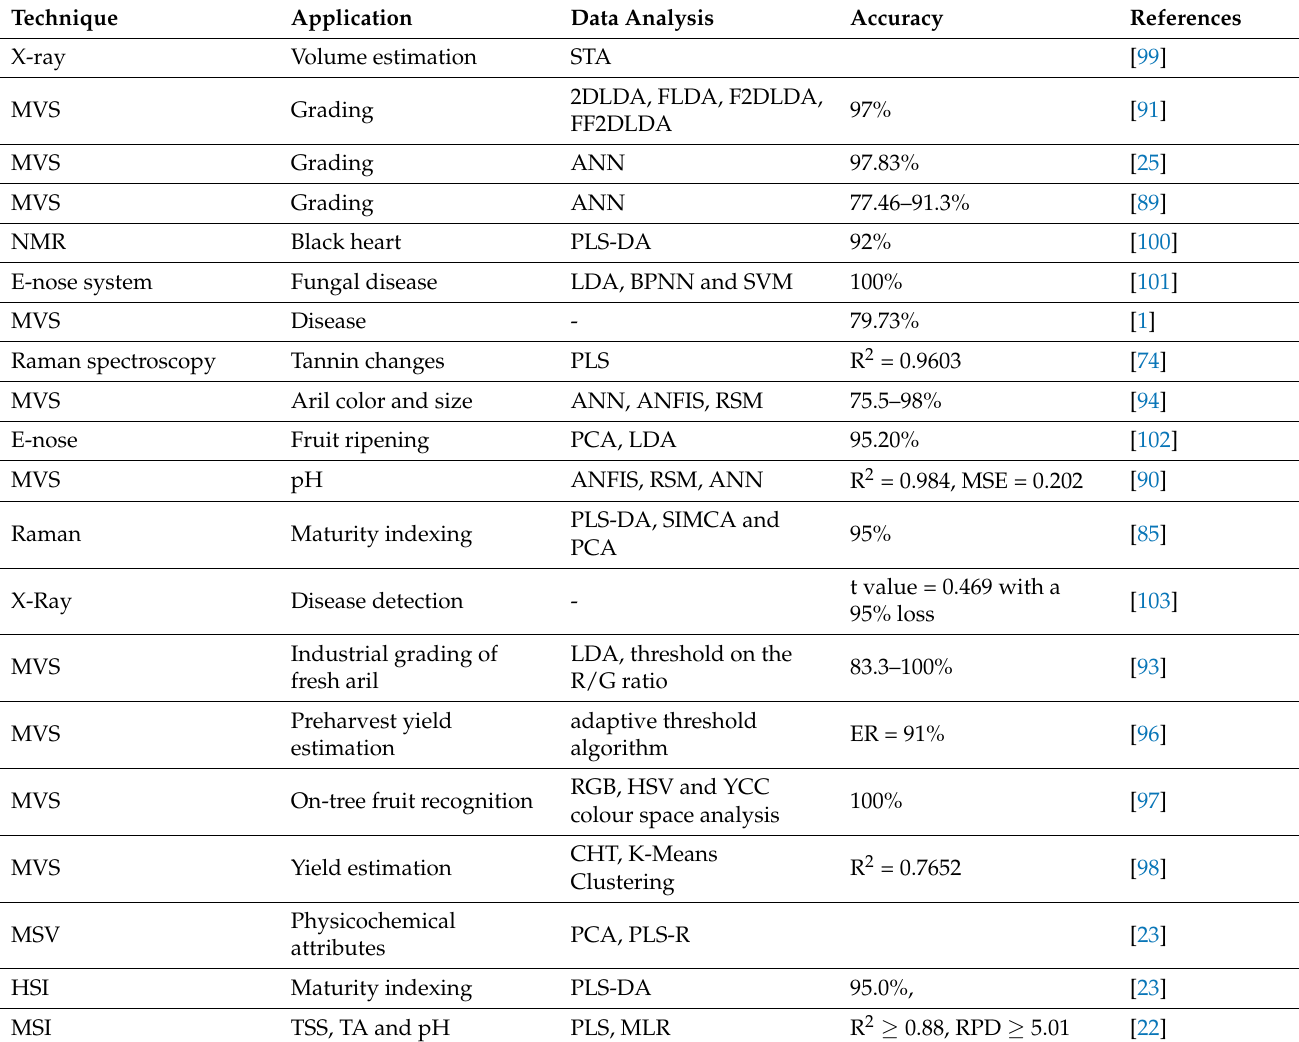
Table 4. Summary of application of different non-destructive assessment for pomegranate quality